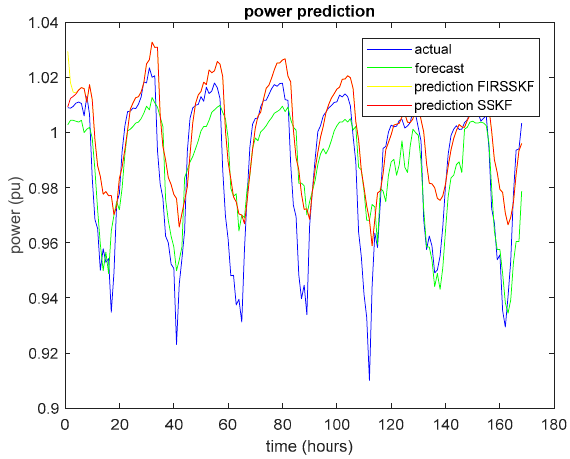
Figure 8. SSKF is equivalent to FIRSSKF.